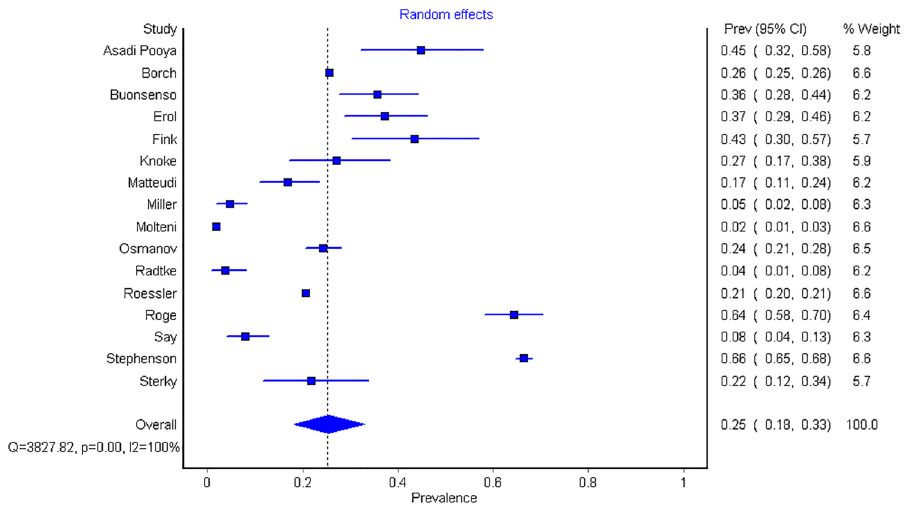
Figure 3. Forest plot of pooled prevalence of long-COVID overall in children and